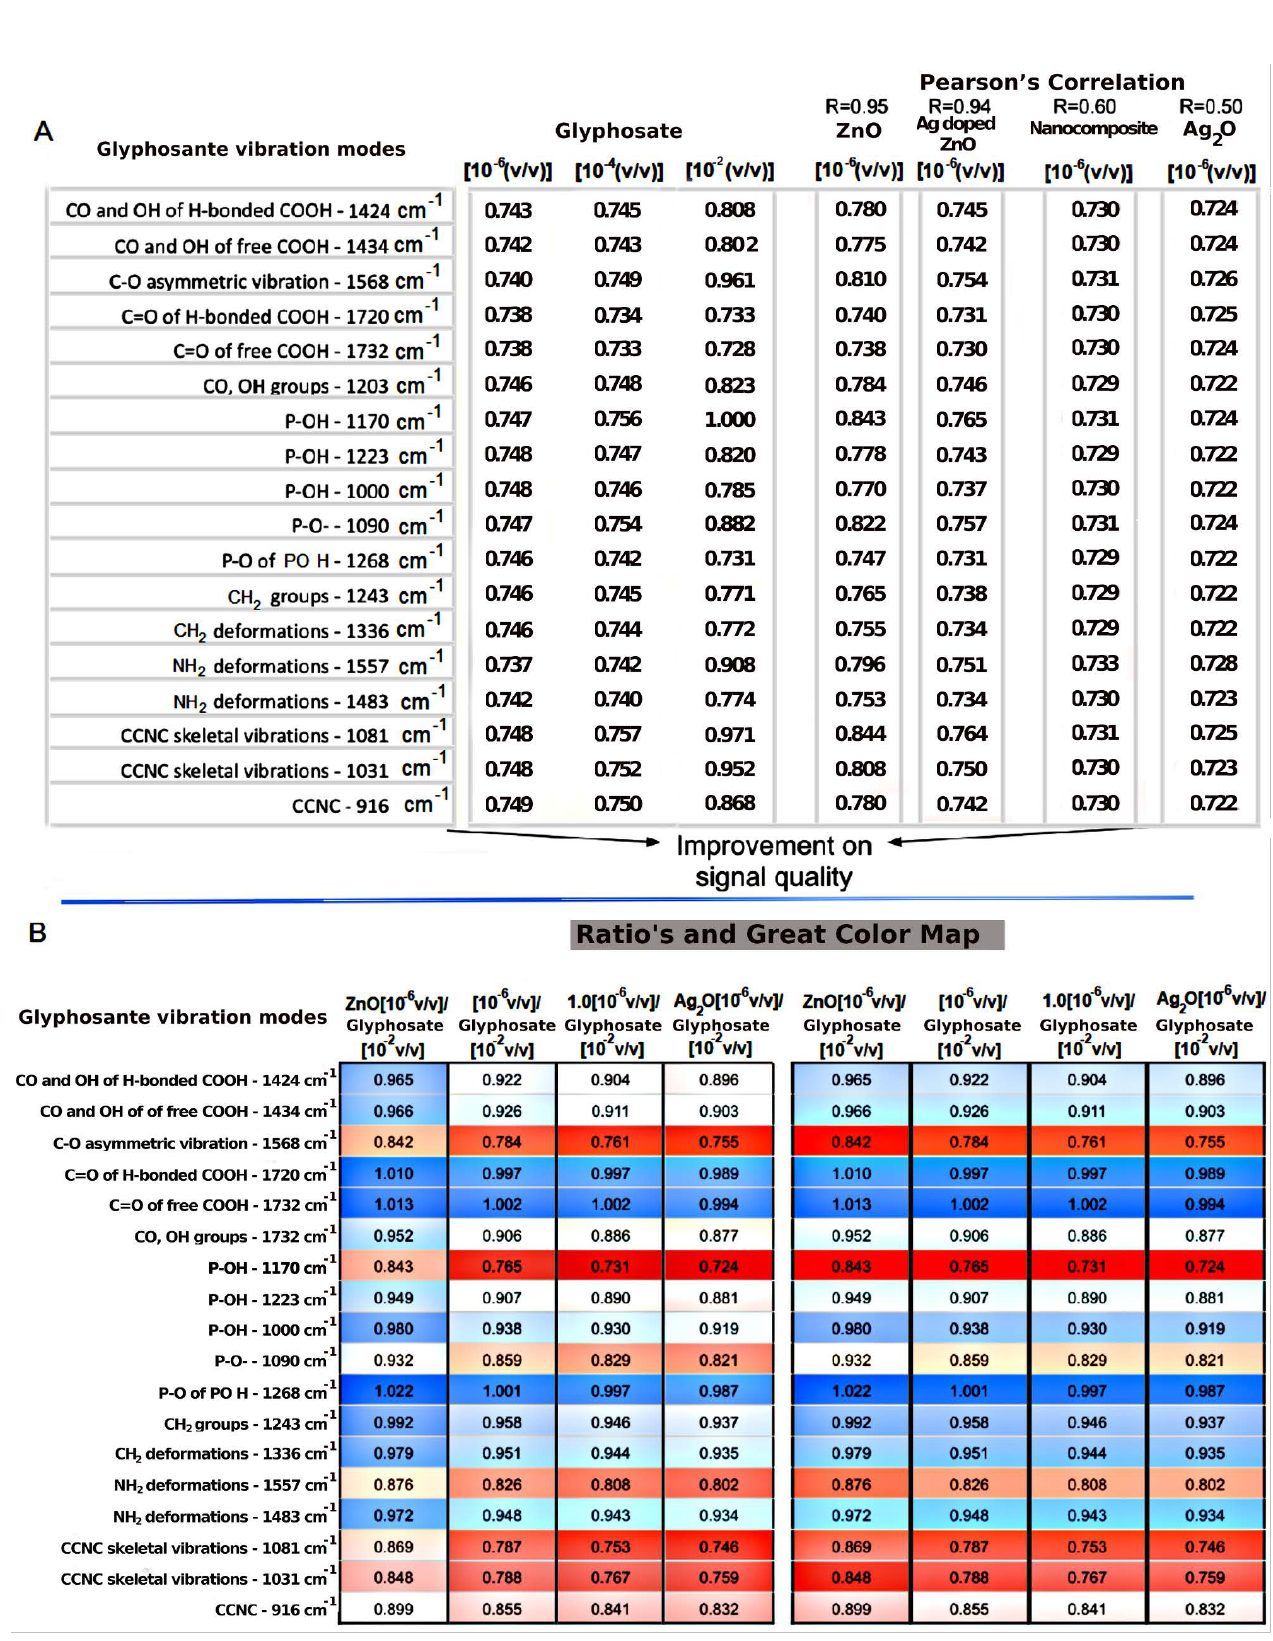
Figure 4. ( A ) The frequency mode of each molecular group that makes up glyphosate before and after interacting with nanomaterials. ( B ) An energy color scale related to frequency intensity changes when interacting with nanomaterials (ZnO, Ag 2 O, and Ag-doped ZnO (Ag ZnO)), and nanocomposite (ZnO